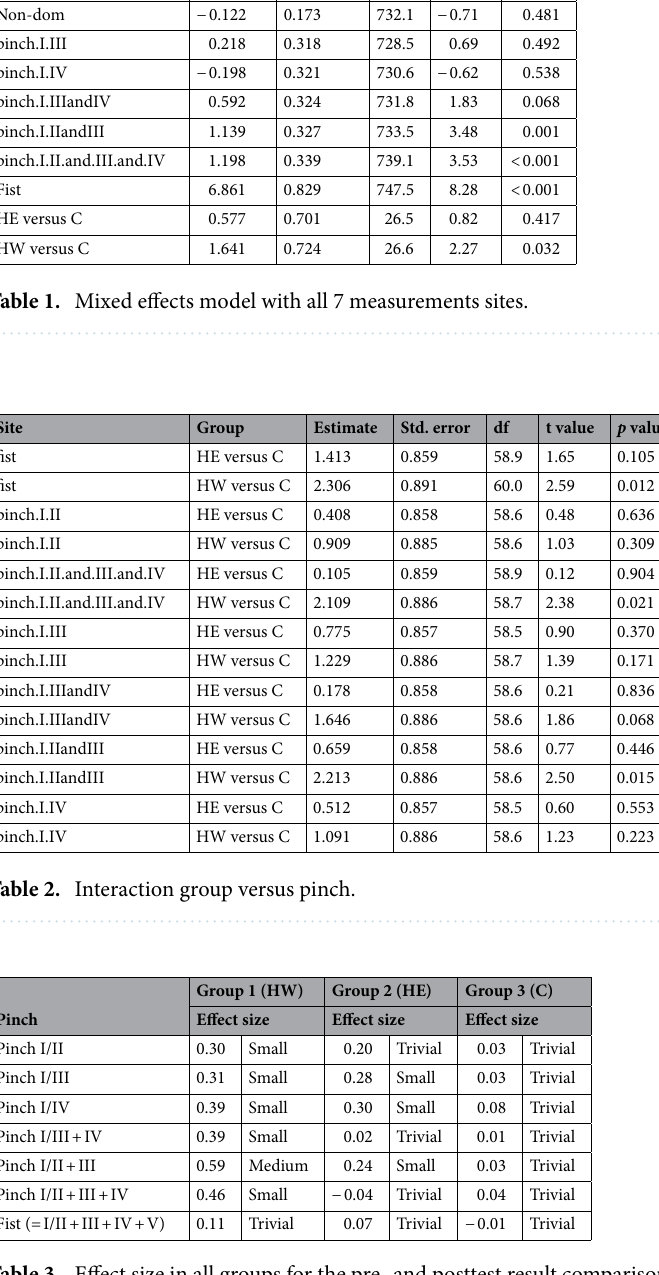
Table 3. Effect size in all groups for the pre- and posttest result